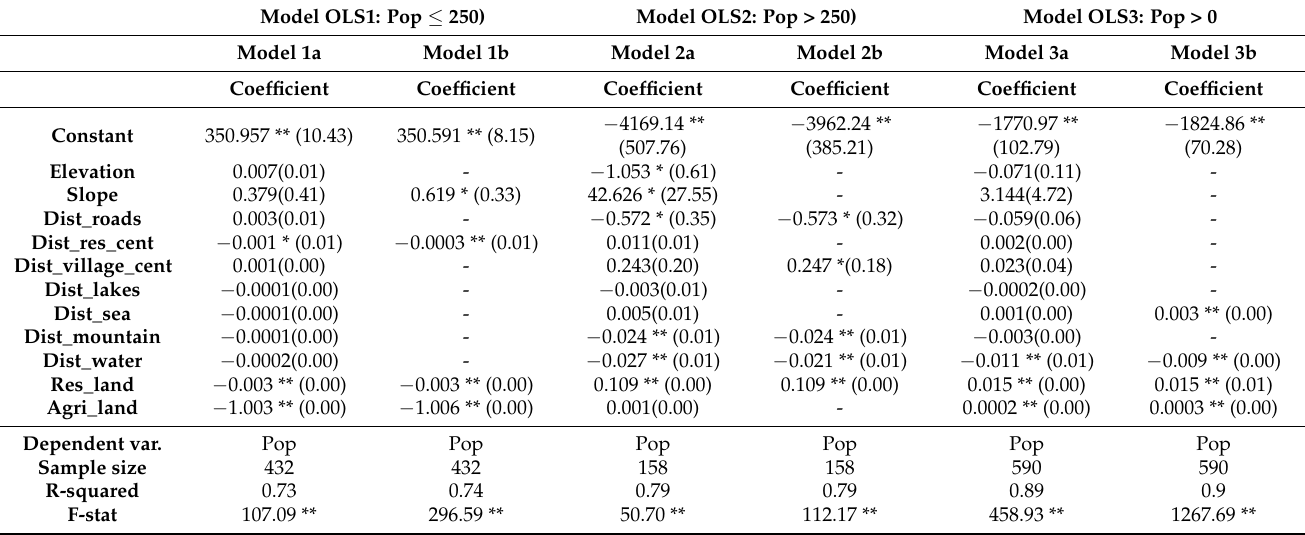
Table 3. Estimates from the OLS regression model.